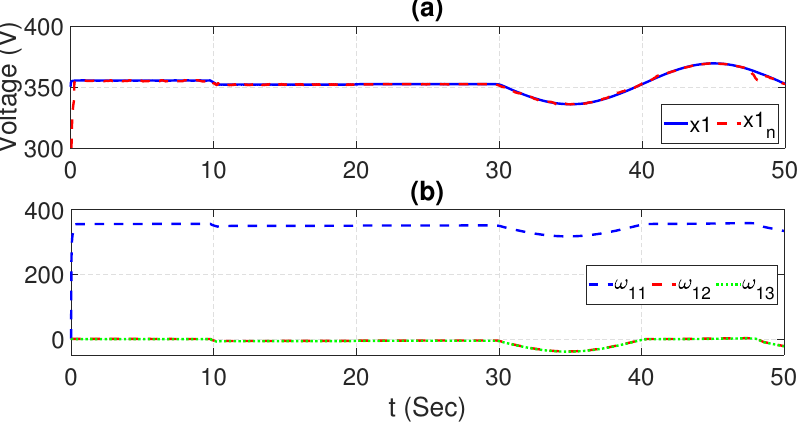
Figure 1. Voltage identification ( a ) and NN’s weights ( b ).